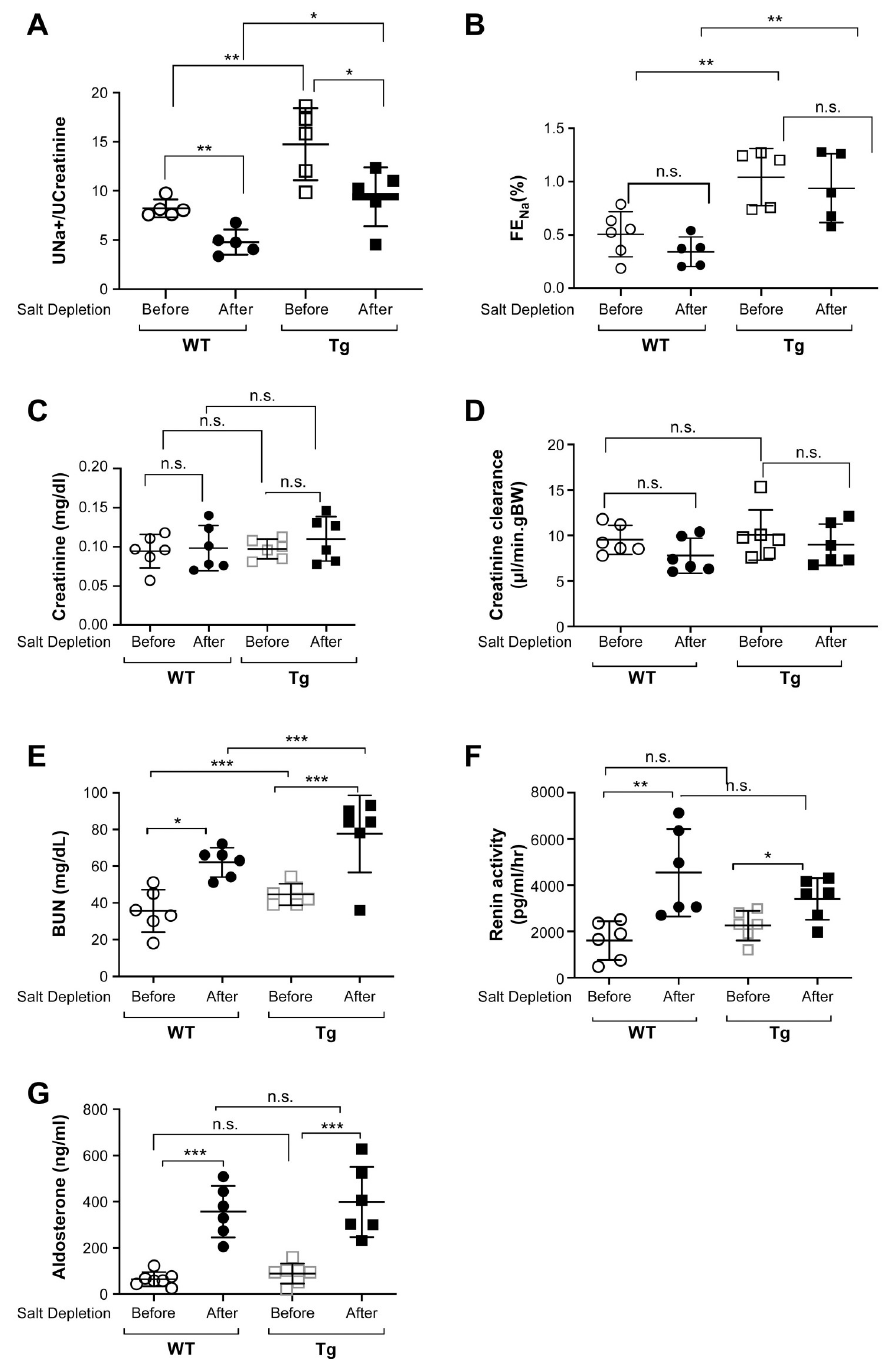
Fig 2. Kidney function and sodium homeostasis-related parameters in Vpr Tg mice. ( A ) Urinary sodium excretion (UNaV, ratio of urinary sodium in mmol/Lto urine creatinine in mmol/L) was significantly elevated in Tg mice compared with WT littermates, before and after feeding a low salt diet. ( B ) Fractional excretion of sodium (FENa) was higher in Tg compared with WT mice before and after a low salt diet. ( C ) Serum creatinine concentrations and ( D ) creatinine clearances (Ccr) were not different among the groups. ( E ) Blood urea nitrogen (BUN) concentration was higher in Tg that WT mice before and after allow salt diet. ( F ) Plasma renin activity and ( G) plasma aldosterone concentrations were increased on low salt diet but were similar in WT and Tg mice. n = 5–6. n.s., not significant; � P < 0.05, �� P < 0.01, ��� P < 0.001, ANOVA, Bonferroni correction.